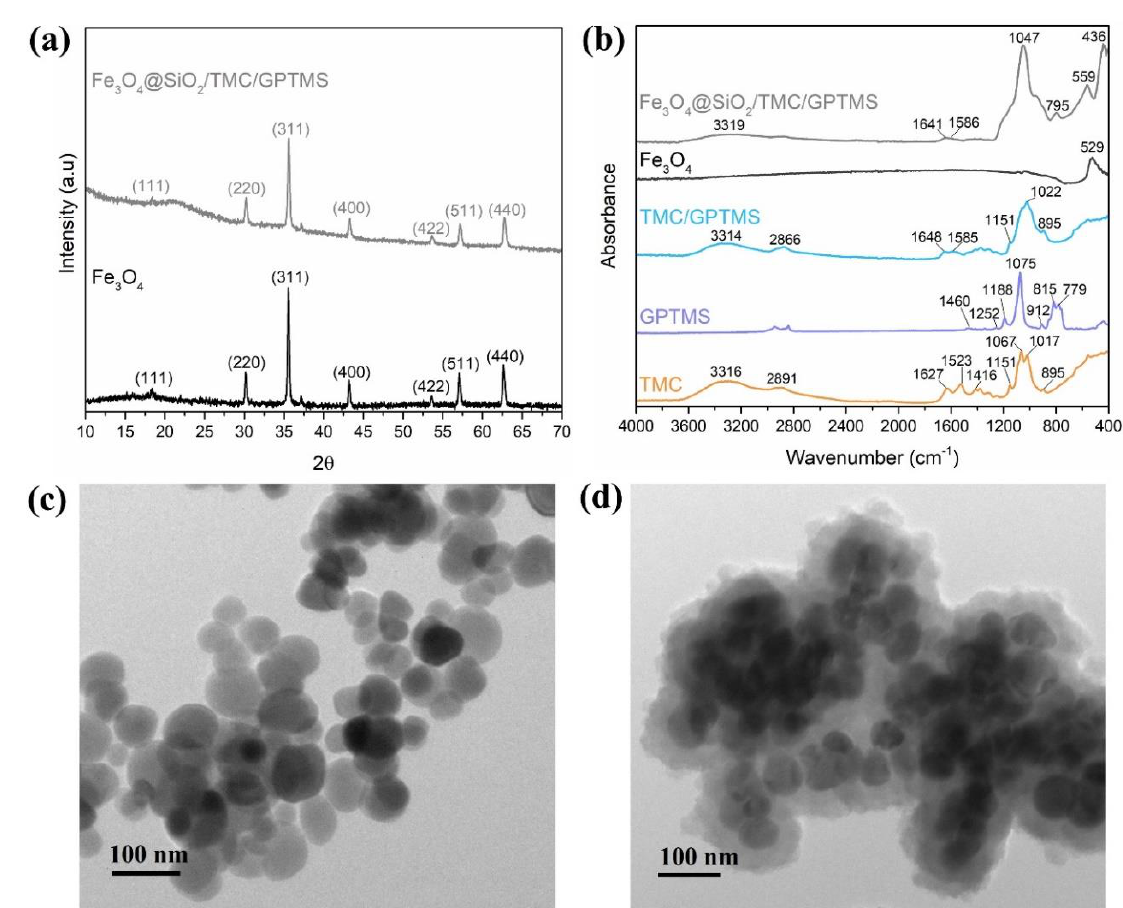
Figure 1. ( a ) Powder XRD patterns of Fe 3 O 4 and Fe 3 O 4 @SiO 2 /TMC/GPTMS particles; ( b ) ATR-FTIR spectra of TMC, GPTMS, TMC/GPTMS, Fe 3 O 4 , and Fe 3 O 4 @SiO 2 /TMC/GPTMS materials; and TEM images of ( c ) Fe 3 O 4 and ( d ) Fe 3 O 4 @SiO 2 /TMC/GPTMS particles.